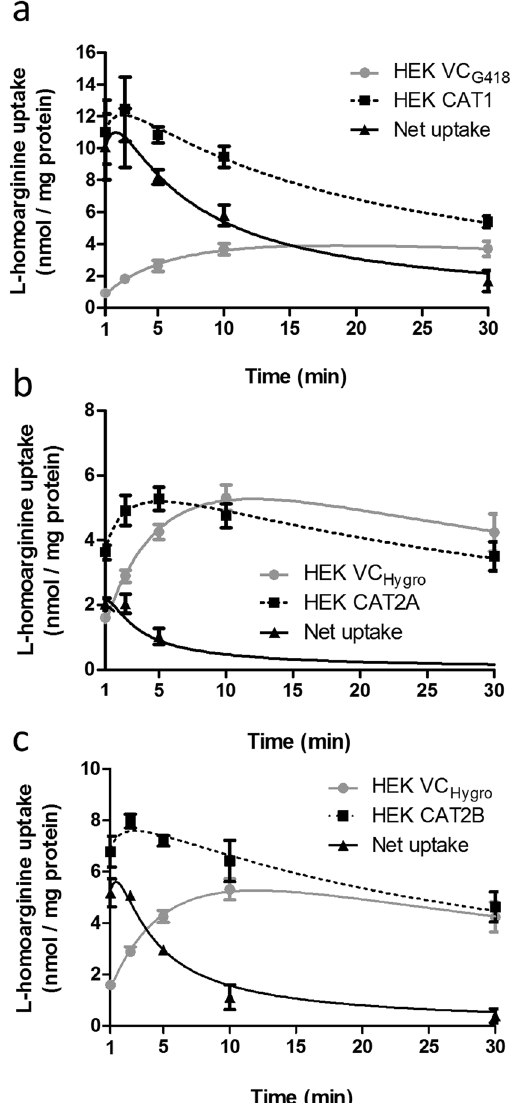
Figure 2. Time-dependent uptake of L-homoarginine in HEK cells overexpressing CAT1 ( a ), CAT2A ( b ) or CAT2B ( c ). Cells were incubated for 1, 2.5, 5, 10, and 30 min at 37 °C with 100 μ M L-homoarginine. Each data point is n = 6. *** p < 0.001 as compared to suitable cells (HEK VC G418 or HEK VC Hygro ) containing only an empty